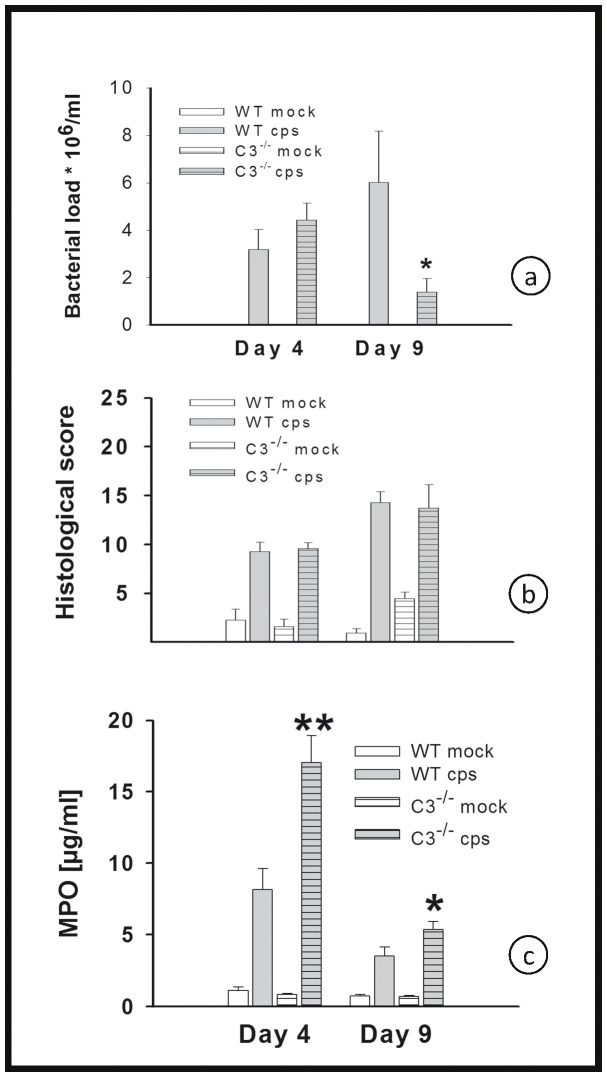
Figure
2. Bacterial load, histological score and MPO of C3−/− and WT mice in high-dose infection. Mice were infected with 104 IFU of C. psittaci DC15 or mock-infected and sacrificed on days 4 or 9 p.i. Bacterial load (panel a), histological score (panel b) and granulocyte marker enzyme MPO (panel c) in lungs of C3−/− and WT mice were determined. The figure shows data obtained from C. psittaci-infected mice (cps, gray bars), mock-infected mice (white bars), WT mice (open bars) and C3−/− (horizontally hatched bars). Means ± SEM are depicted. * indicates significant (p<0.05) differences between infected knockout as compared to the corresponding infected BL/6J WT mice.